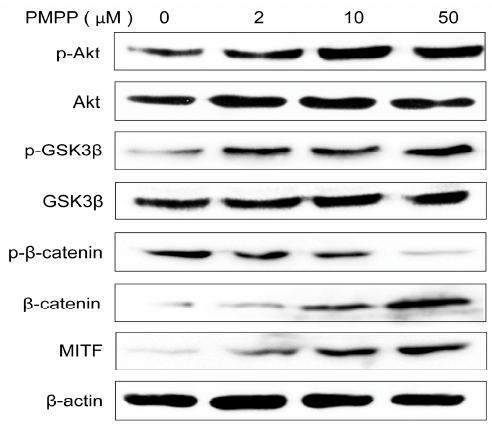
Figure 5. Effects of PMPP on signal transduction proteins that participate in melanogenesis. B16 cells were treated with PMPP at 0, 2, 10, and 50 μ M for 48 h, and the phosphorylation and total of Akt, GSK3 β , β -catenin, and MITF were measured by Western blotting. Equal protein loading amounts were confirmed by β -actin expression.